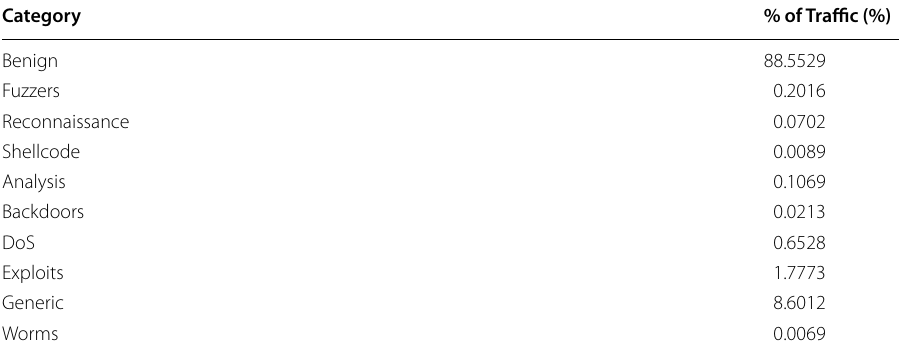
Table 3 % of benign and attack traffic in